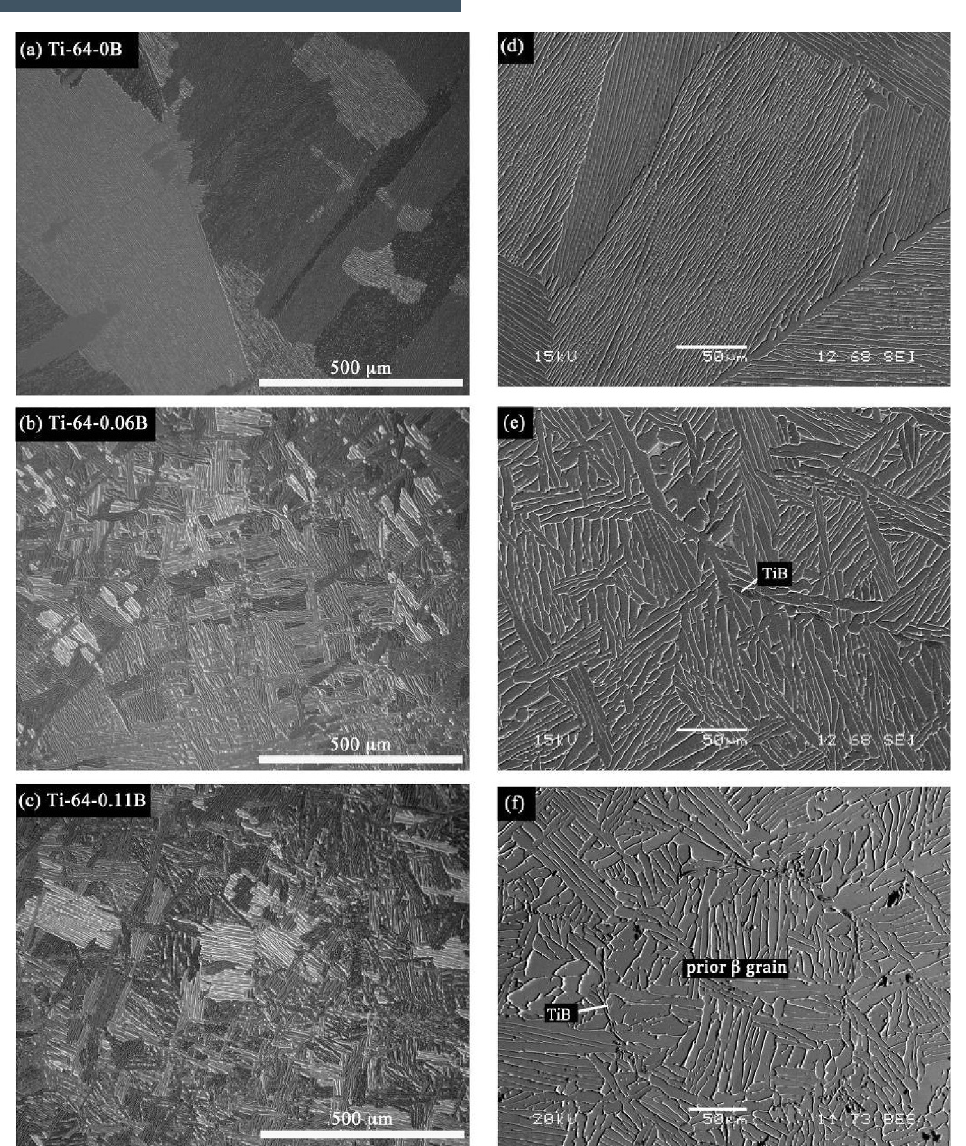
Figure 3. Optical and SEM micrographs of (a, d) Ti-64, (b, e) Ti-64-0.06B and (c, f) Ti-64-0.11B alloys. In (d-f) the α phase is gray, the β phase is white, and the TiB is dark